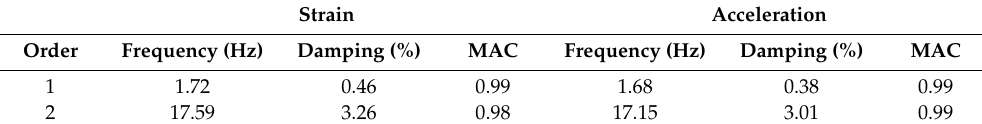
Table 2. Identified modal parameters from the acceleration and strain responses.